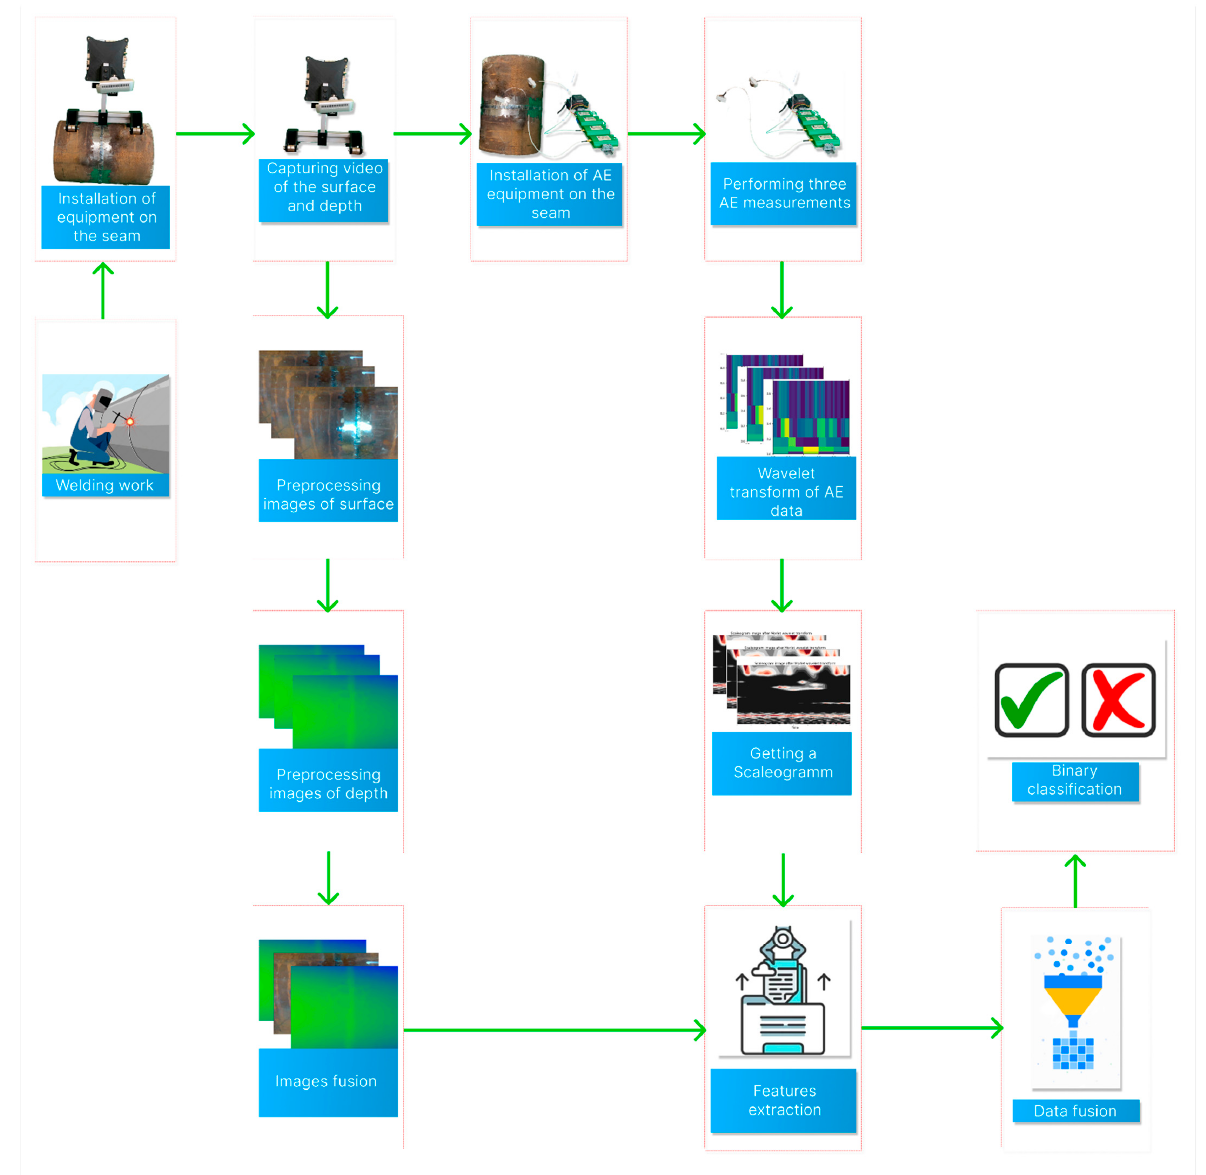
Figure 1. The block diagram of the proposed study.